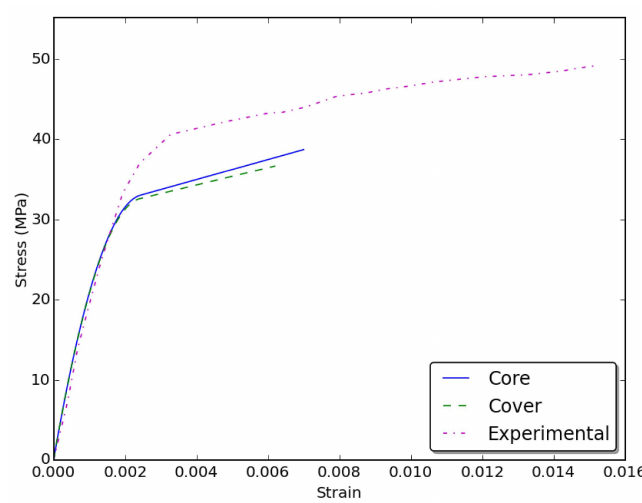
Figure 17. Stress-strain curves for Specimen C30S50N2.